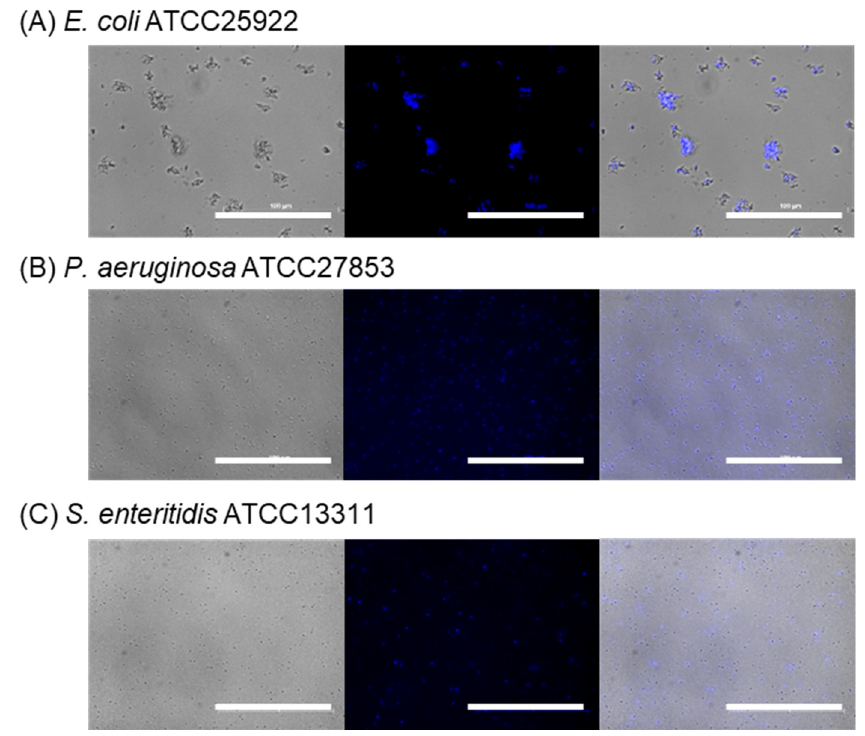
Figure 10. Microscope images of Gram-negative bacteria obtained using BenzoB-PAMAM(+) at a pH of 7.4, adjusted with PBS. [BenzoB-PAMAM(+)] = 3.3 × 10 − 6 M; bacterial concentration was set at OD 600 = 0.3. From left to right: DIC, DAPI, and merged microscopy images. Scale bar = 100 µ m. ( A ) E. coli ATCC25922. ( B ) P. aeruginosa ATCC27853. ( C ) S. enteritidis ATCC13311.